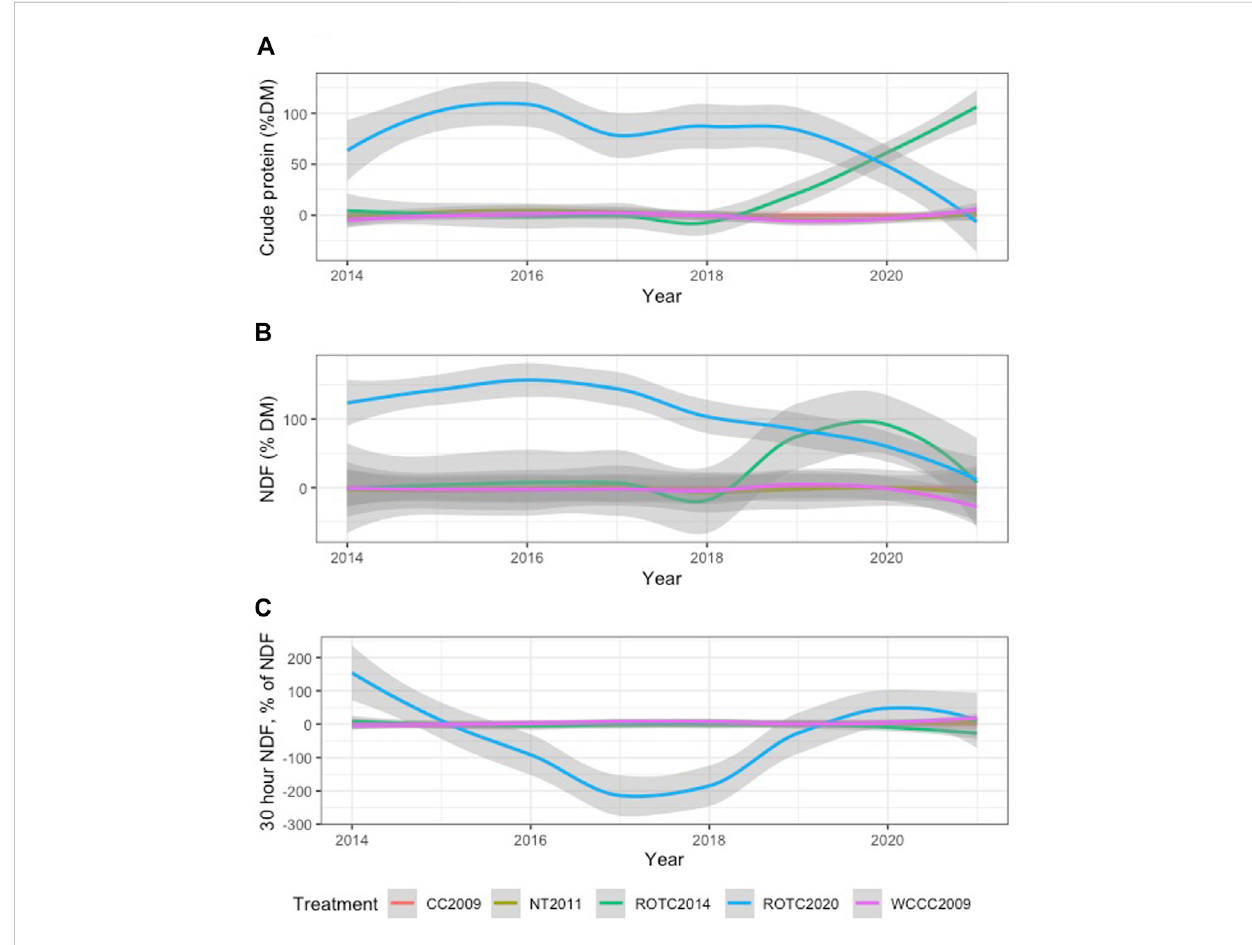
FIGURE 6 Loess plots (locally weighted smoothing) show deviation in forage quality parameters from continuous corn by treatment from 2012 to 2021: (A) Crude protein (B) NDF (C)